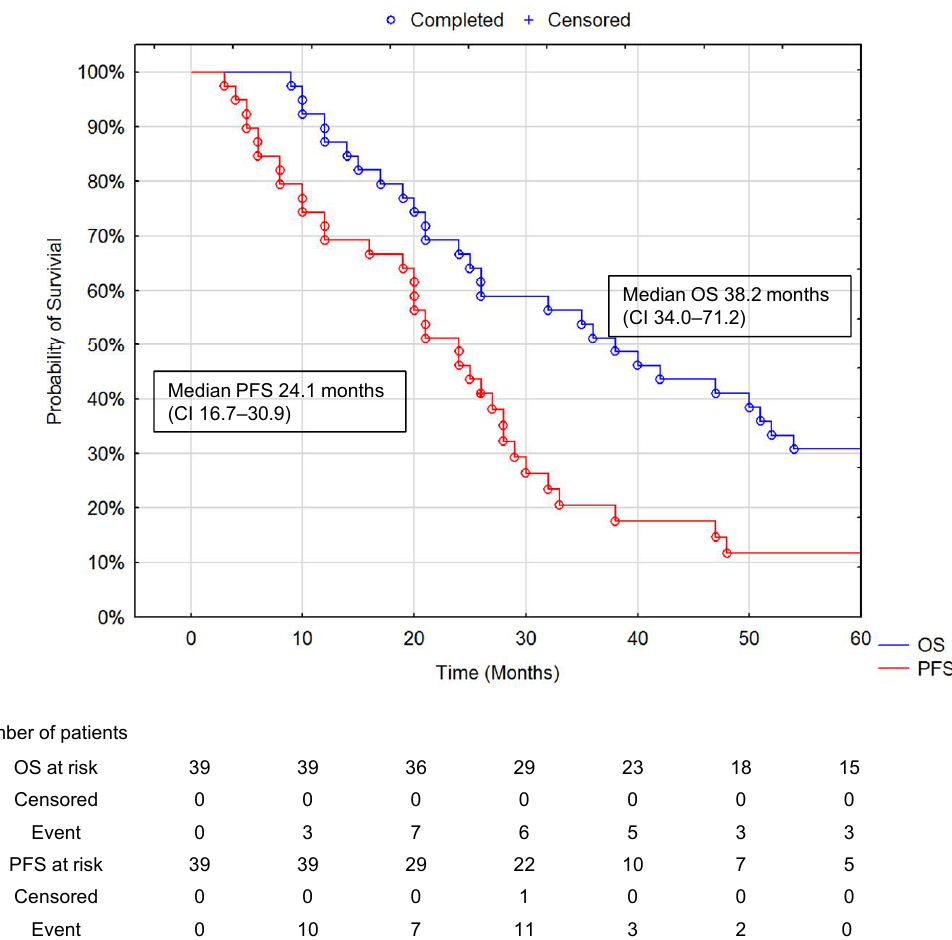
Figure 4. OS and PFS in all patients during follow-up. Median OS 38.2 months (95% CI 34.0–71.2) and median PFS 24.1 months (95% CI 16.7–30.9). Data are presented for all patients who received at least two doses of PRRT during the study. The number of subjects remaining at risk below is 10% of cases in any